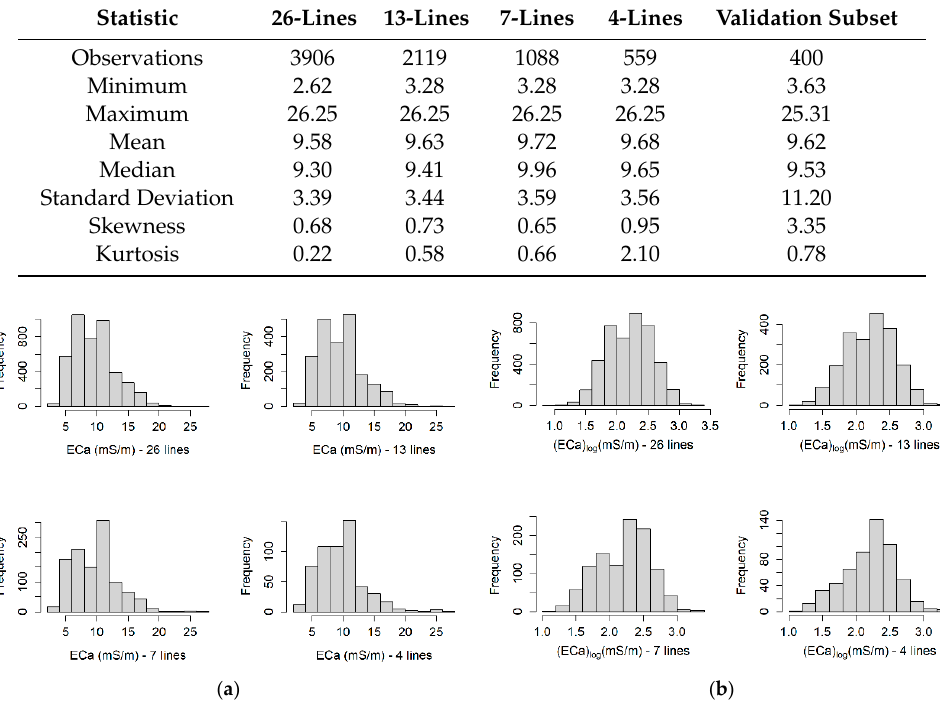
Table 2. Descriptive statistics results for soil ECa datasets for the di ff erent numbers of transect lines (i.e., 26, 13, 7, and 4) and the external validation subset.